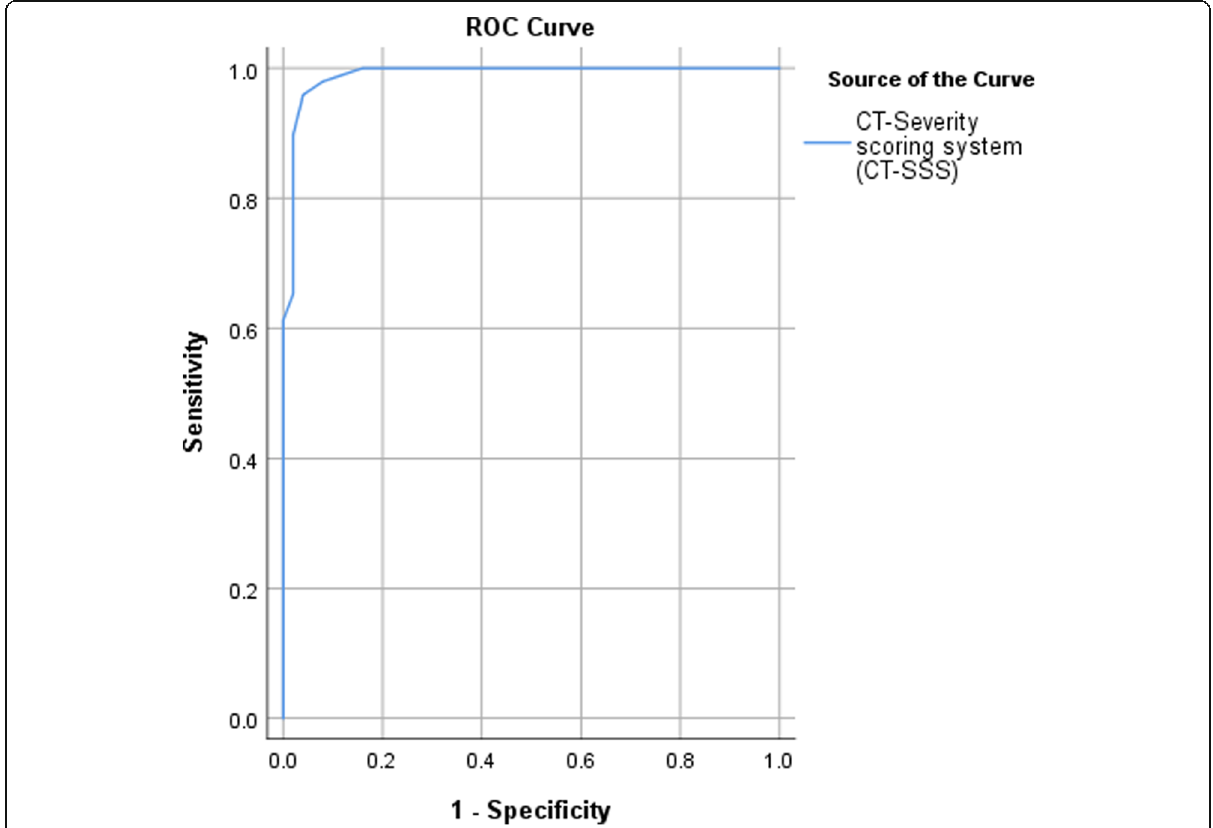
Fig. 4 ROC curve for development of post-COVID syndrome using